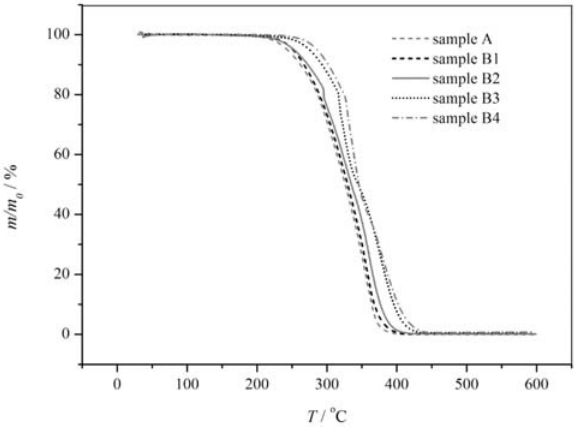
Figure 7. TG curves of PMMA and B-series of ZnO-PMMA com- posites with various addition of